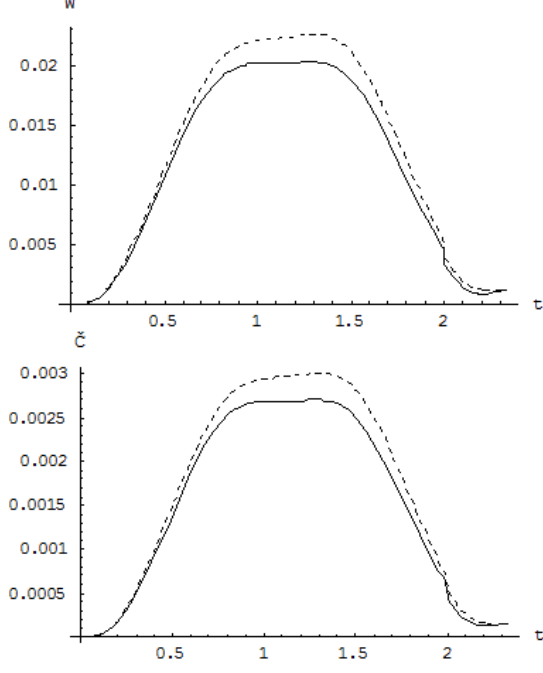
Figure 35: The vertical-torsional motion of the middle of the bridge for υ = 30 m/s and for damped vehicle ( __ ) , simple vehicle ( - - - ). different values of speed υ under the action of a simple ve- hicle and of a damped